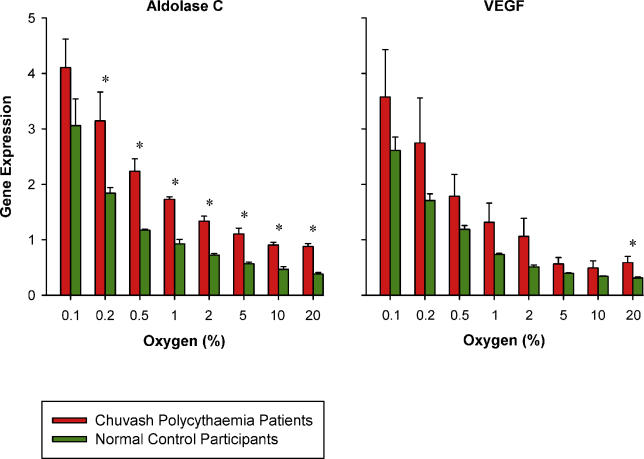
Aldolase C and
VEGF mRNA Expression at Different Oxygen Tensions
Lymphocytes were isolated from venous blood taken from CP patients and normal control participants, and incubated at eight different levels of oxygen tension prior to RNA isolation. Gene expression is shown relative to a standard calibrator sample. Basal gene expression at 20% oxygen was significantly higher in CP patients for both
Aldolase C (A) and
VEGF (B) (
p < 0.05). Both genes were induced by hypoxia, and at the lowest oxygen tension (0.1%) expression was no longer significantly different for either gene. Values are mean ± standard error of the mean. Asterisks indicate
p < 0.05 (unpaired
t-test).